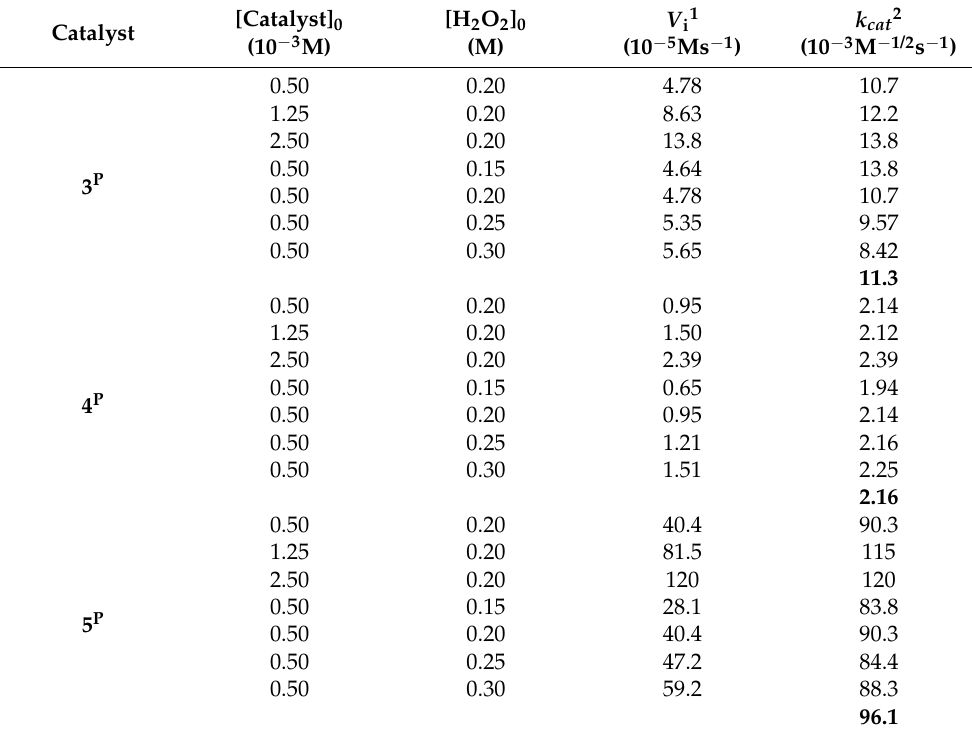
from gas volumetric measurements in MeCN at 298